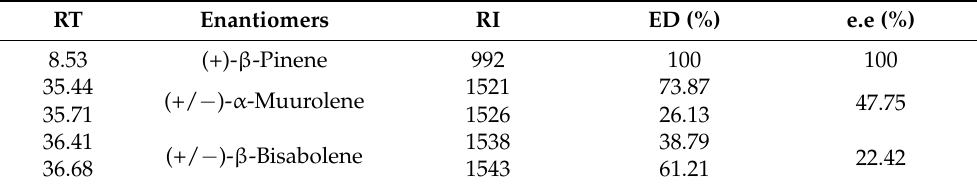
Table 3. Chiral compounds present in the essential oil of the leaves from Peperomia inaequalifolia